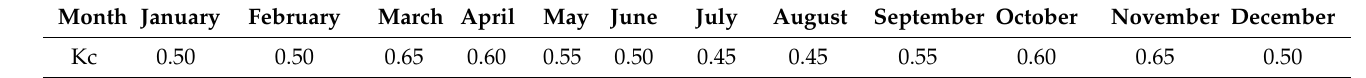
Table 2. Crop coefficients for an olive orchard with 60% of ground cover